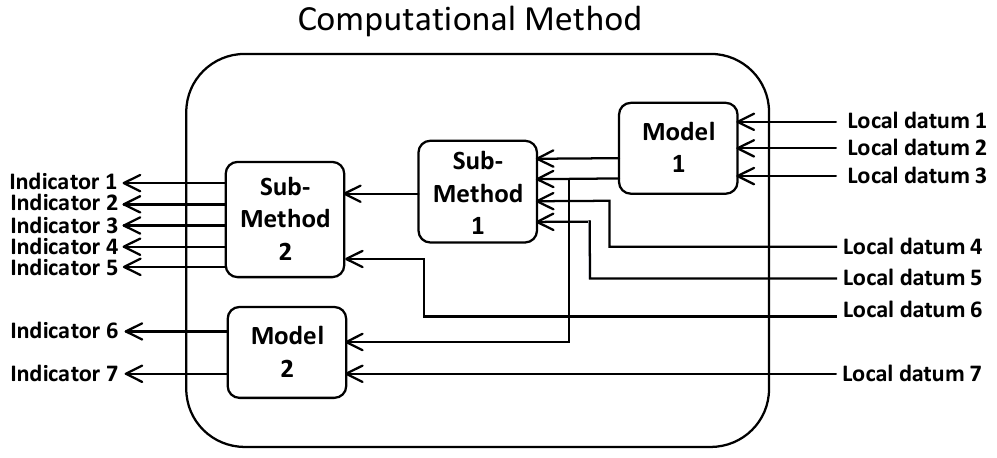
Figure 3. An example of a first step of decomposition of a computational method. Any indicator and/or local datum may be compound, i.e., it may comprise a structure of simpler data.